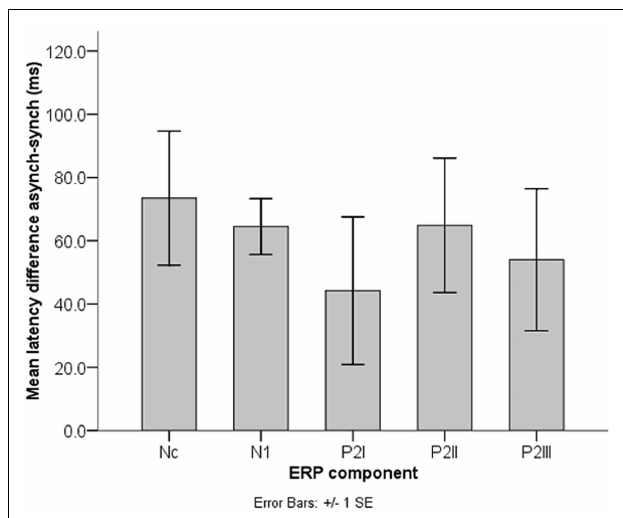
FIGURE 7 | Nc, N1, and P2 latency shifts ( n = 15). Latency differences between synchronous and asynchronous stimuli did not differ significantly between the ERP components and were always significantly smaller than the AV asynchrony of